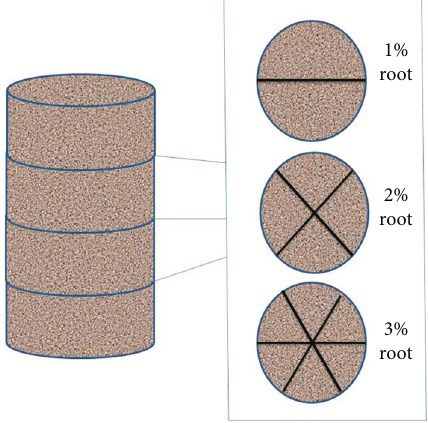
Figure 3: The arrangement of the rope in the sample. Table 2: Variables and values. Level